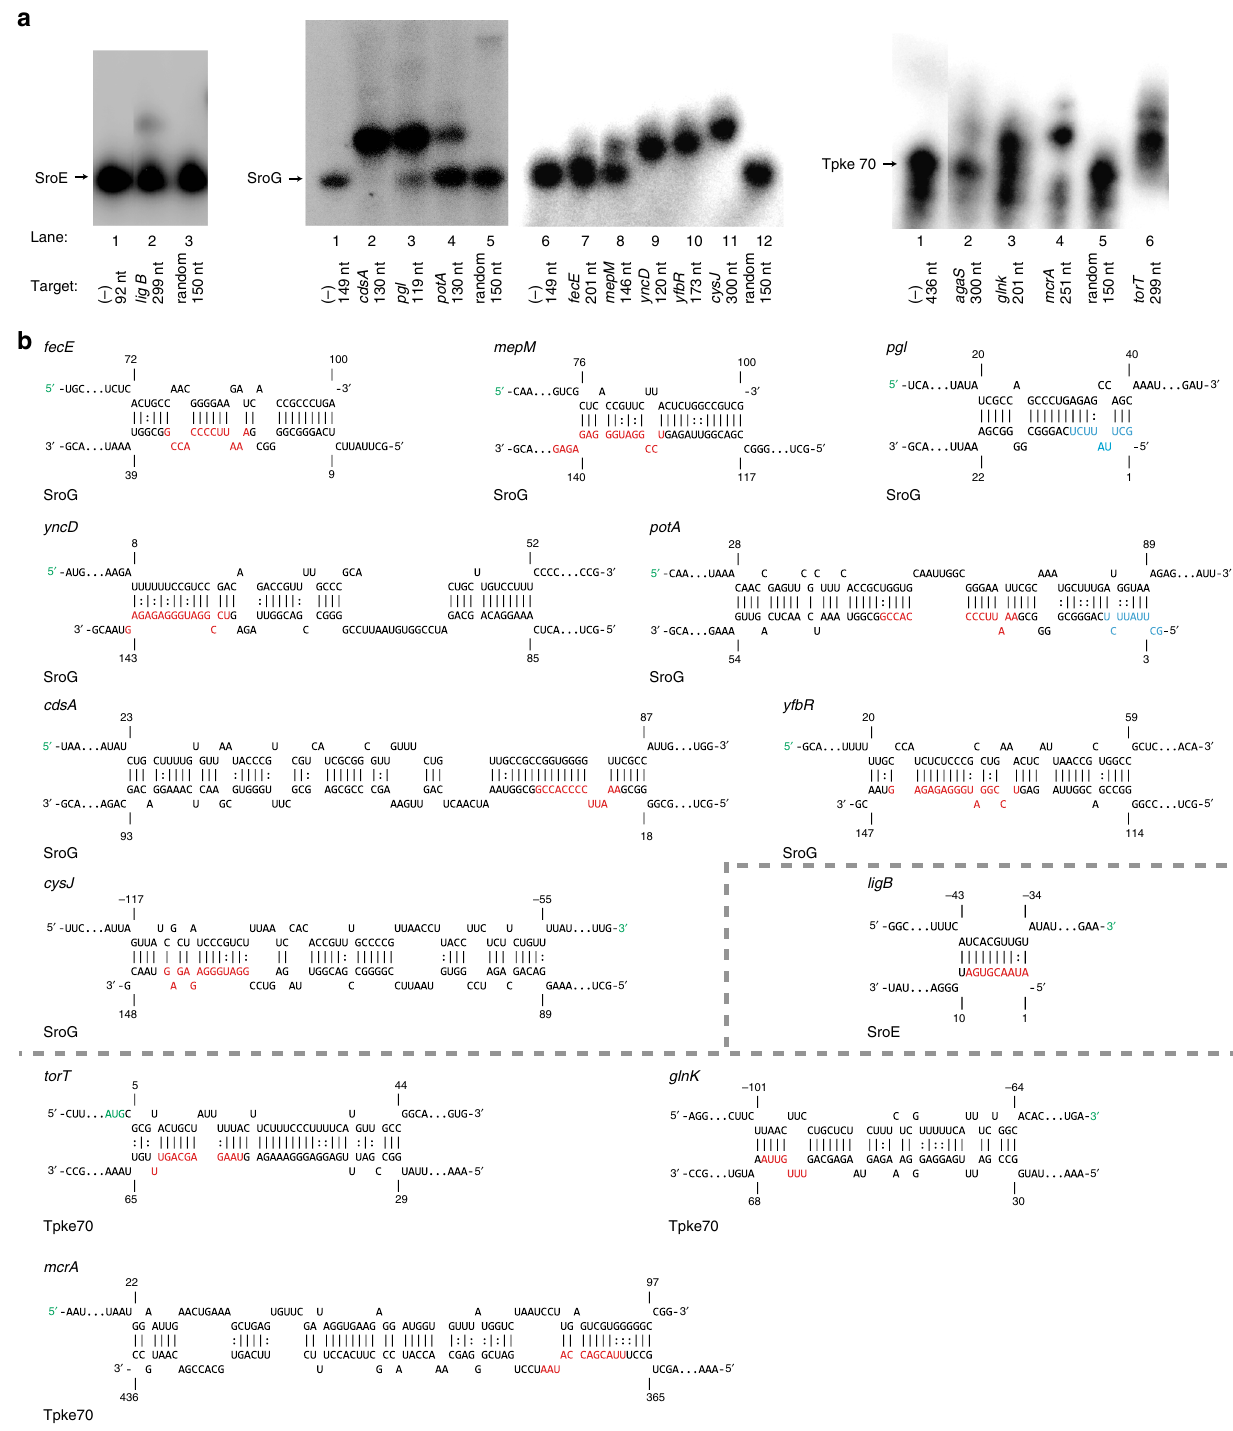
Fig. 5 Validated sRNA:mRNA interactions support the use of INTERFACE insights to inform sRNA target predictions. a All positive EMSA results from the benchmarking study are pictured with respective controls (i.e., sRNA only and sRNA + random sequence). A 1:10 molar sRNA:mRNA ratio was used in all cases. sRNA names are indicated above corresponding EMSA results, and mRNA names and lengths of representative fragments chosen for validation are indicated under each respective lane. b Predicted IntaRNA interactions are shown for each positive result. Likely functional regions that were selected via the pipeline for selection of “ true ” predicted mRNA targets of under-characterized sRNAs (Fig. 4b) are highlighted in colors corresponding to their observed accessibilities (red = high, blue = low). mRNA positions are indication, in which the 5 ′ -UTR corresponds to negative position values relative to the start codon. Start codon positions ( fi rst nucleotide = + 1) are highlighted in